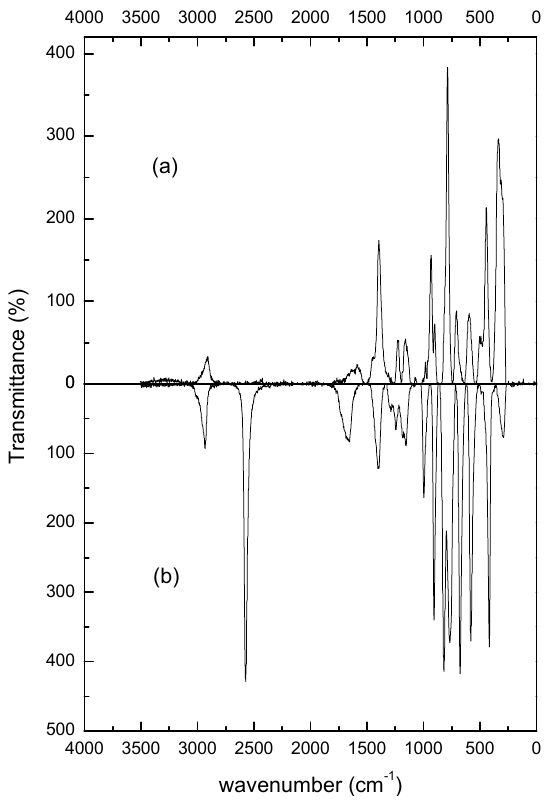
Figure 4. X-ray diffraction (XRD) pattern diagrams of the ZnS:Mn-MAA NCs prepared at: ( a ) pH 2; ( b ) pH 7; and ( c ) pH 12. The diagram ( d ) is a reference ZnS bulk solid pattern in a cubic zinc blend phase (JCPDS 05-0566).